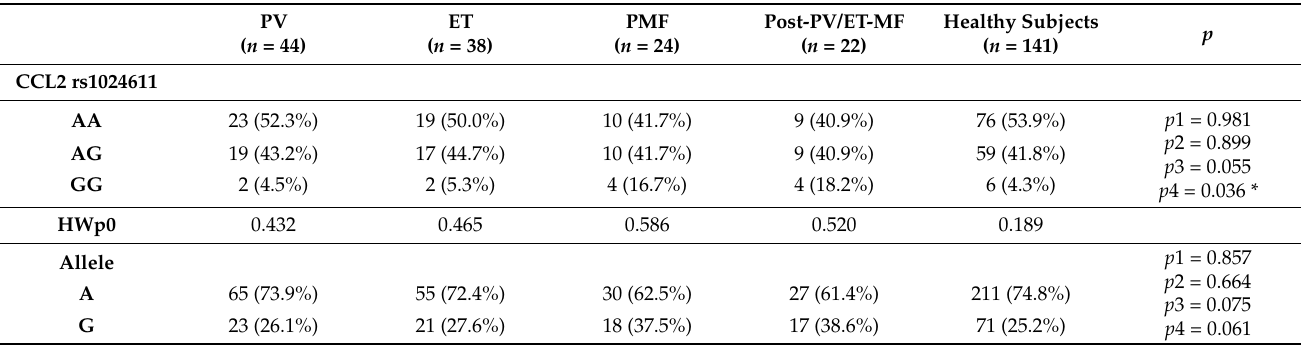
Table 2. Genotyping of CCL2 rs1024611 and risk allele frequency among Philadelphia-negative